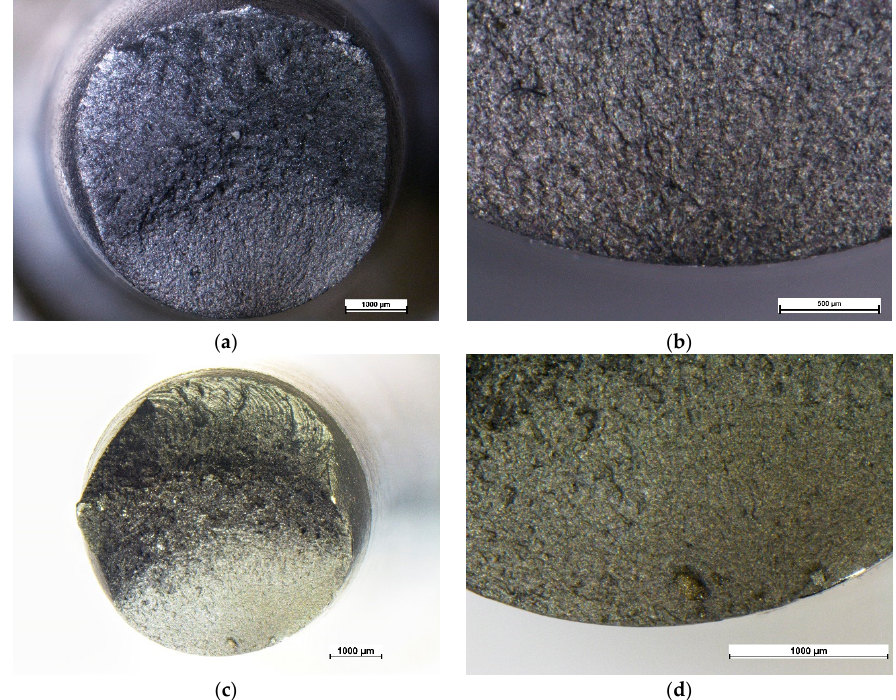
Figure 9. Optical images of the fracture surface of a welded AISI304—ASTM A105 specimen tested to fatigue in air (F) ( a ) Top view of the sample fracture surface tested at 500 MPa; ( b ) close-up of the fatigue fracture surface and crack nucleation area of the sample ( a ); ( c ) top view of the sample fracture surface tested at 450 MPa; ( d ) close-up of the fatigue fracture surface and crack nucleation area of the sample ( c ).